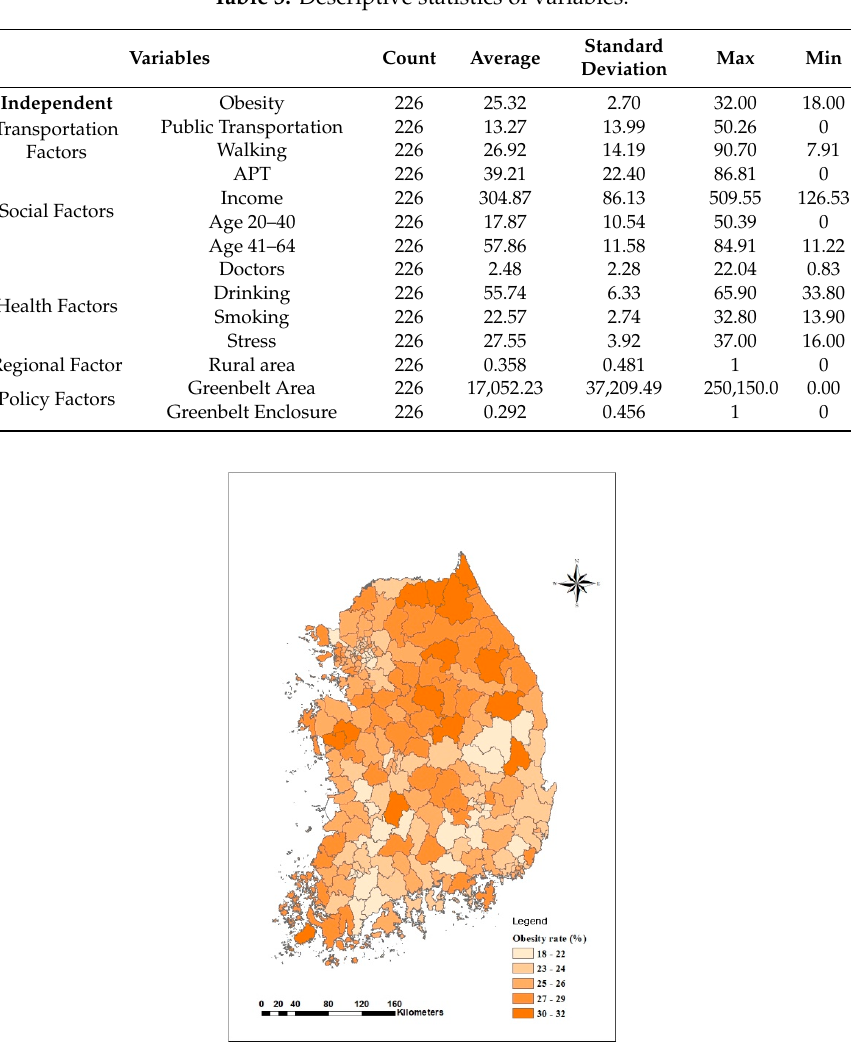
Figure 3. Distribution of obesity rate in Korea in 2015.